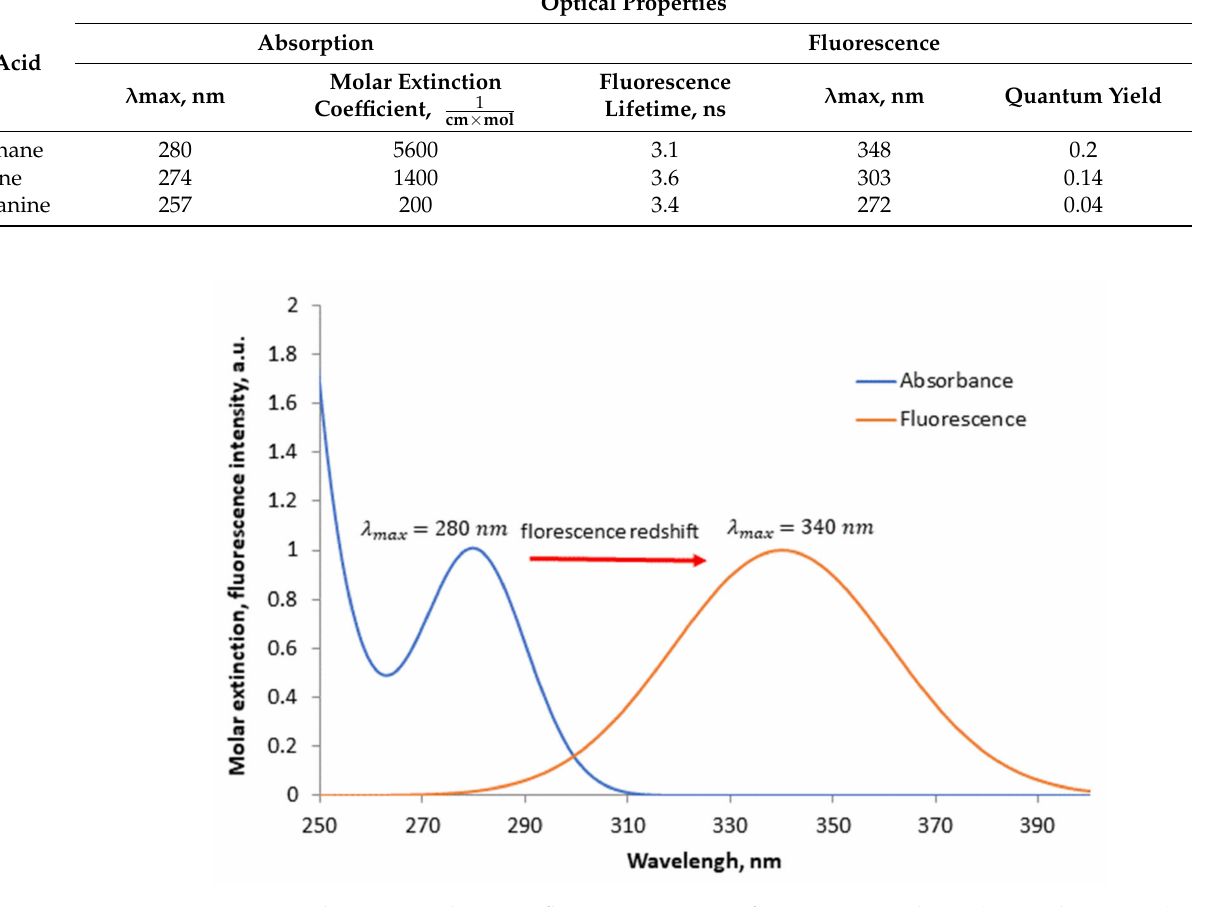
Figure 4. Absorption and intrinsic fluorescence spectra of HSA in water solution (a.u.—arbitrary